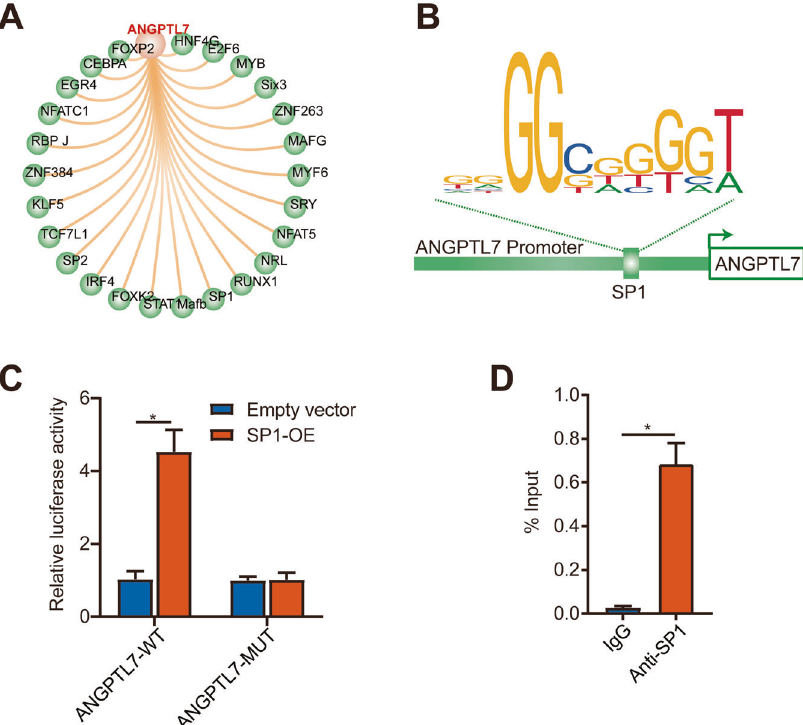
Fig. 5 Relationship between SP1 and ANGPTL7. A Potential transcription factors of ANGPTL7 predicted using the UCSC Genome Browser. B Sites of SP1 predicted to bind to the ANGPTL7 promoter. C , D The binding relationship between ANGPTL7 and SP1 was examined by dual- luciferase reporter and ChIP assays. N = 3 from three biological replicates. * P <